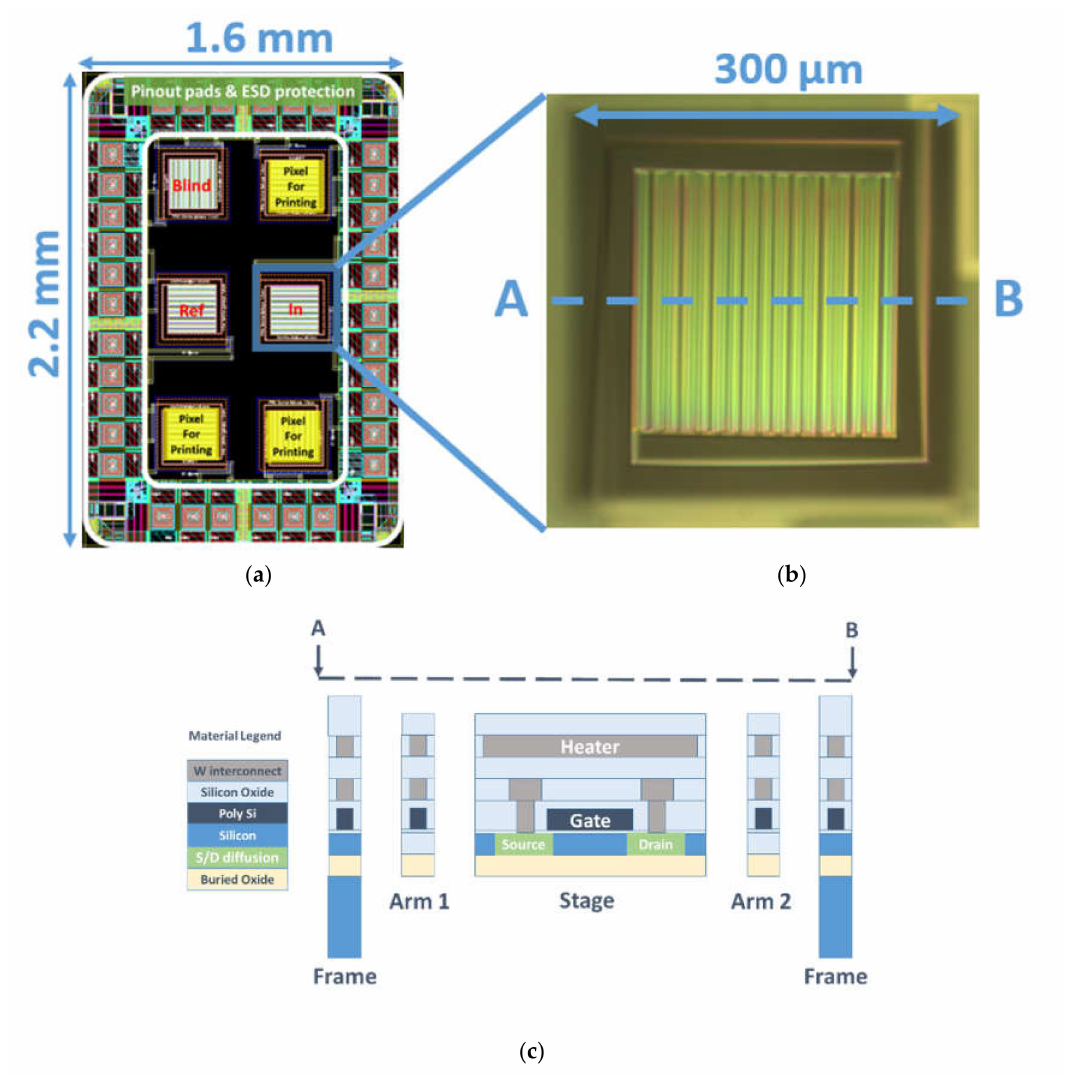
Figure 2. Overview of typical GMOS sensor die and pixel construction: ( a ) GMOS die layout containing three pixels for catalytic layer, one reference (“Blind”) and two auxiliary pixels (“In” and “Ref”) for stabilizing operational point of the electrical readout [22]; ( b ) optical image of released transistor pixel without catalytic layer; ( c ) cross section on plane A–B of released